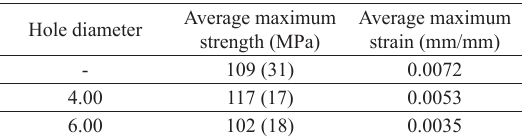
Figure 2. Average values of carbon/PPS specimens with and without holes. Table 3. Average flexural strength in open hole specimens of Carbon /PPS.